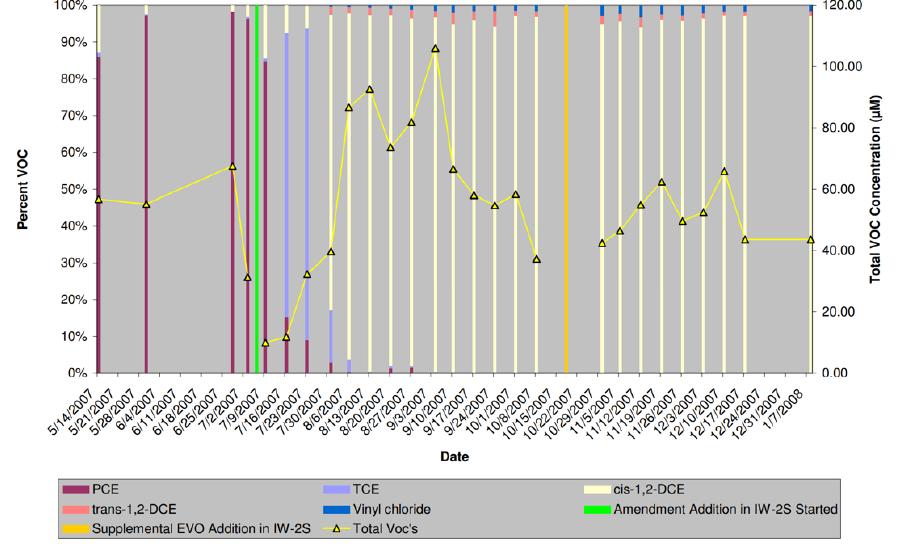
Figure 10. Comprehensive test cell data summary: EVO + hydrogen gas, SMW-3S% VOC, and total VOC concentration.